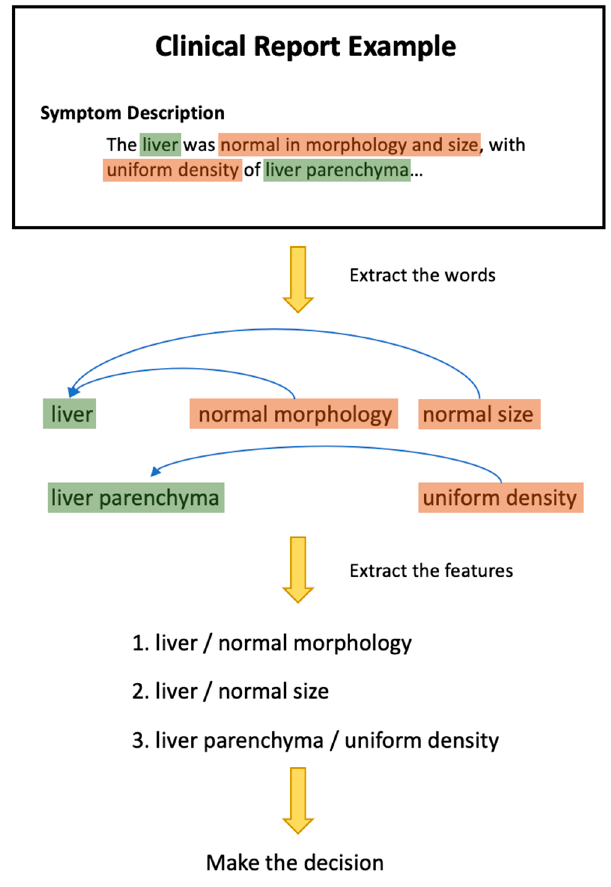
Figure 1. An example of CAD using NLP.